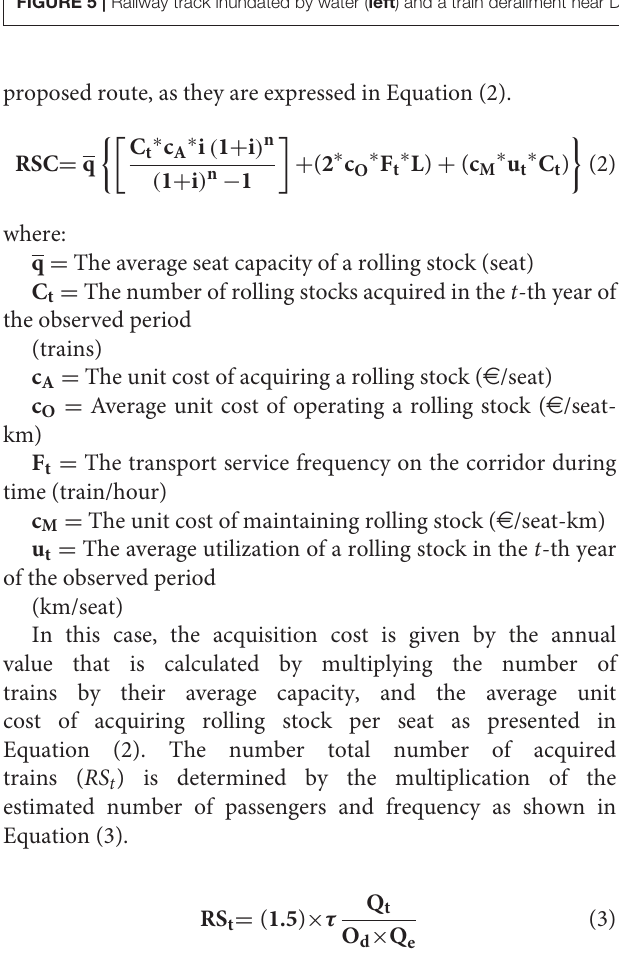
FIGURE 5 | Railway track inundated by water ( left ) and a train derailment near Dammam ( right ). Source: (Arabnews, 2017a).